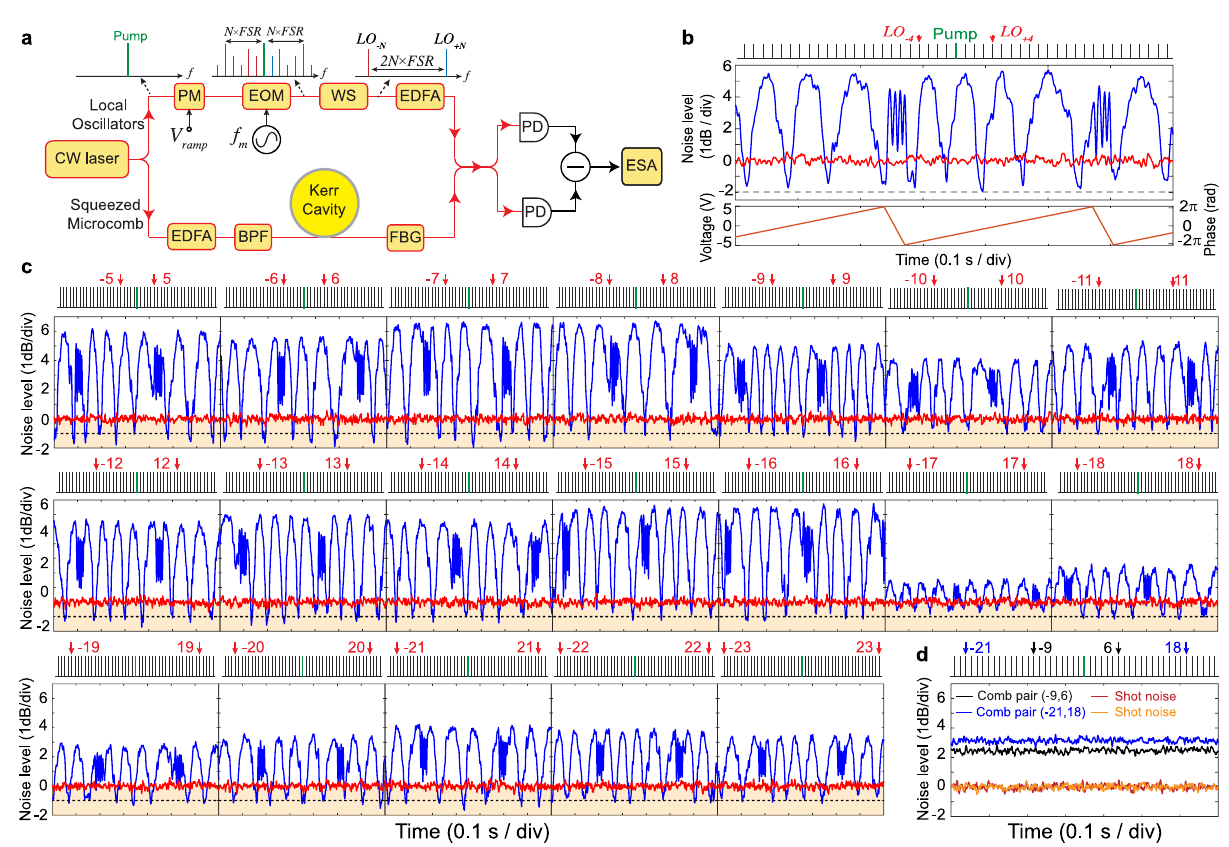
Fig. 2 Two-mode squeezing measurement of 20 comb pairs (40 qumodes) from the microresonator. a Simpli fi ed experimental schematic. A continuous- wave (cw) laser is split to pump the resonator and drive the local oscillators (LOs). The LOs are derived from an electro-optic modulation (EOM) frequency comb, with a comb spacing (modulation frequency) of f m . A line-by-line waveshaper (WS) is used to select a pair of comb lines as the bichromatic local oscillators. The phase of the LOs can be tuned by a phase modulator (PM). The LOs and the squeezed microcombs are combined by a 50/50 coupler and are detected on balanced photodiodes (PDs). The noise level is characterized on an electrical spectrum analyzer (ESA). In the squeezed microcomb path, a fi ber-Bragg grating (FBG) fi lter is used to block the strong pump light. Erbium-doped fi ber ampli fi ers (EDFAs) and optical bandpass fi lter (BPF) are also shown in the fi gure. b Representative quadrature noise variance (blue) relative to shot noise (red) as a function of time for qumodes − 4 and 4 (indicated with red arrows). The lower panel illustrates the ramp waveform applied to the phase modulator to ramp the phase of the LOs periodically with time. 1.6 dB squeezing and 5.5 dB anti-squeezing are directly observed. A dashed black line indicates 2 dB below shot noise level. c Quadrature noise variances (blue) relative to shot noise (red) of all 40 qumodes. The qumodes measured are marked by the red arrows. The regime below the shot noise limit is colored in orange, and a dashed black line indicates 1 dB below the shot noise level. d Quantum correlation check: noise variances show no quantum correlation between uncorrelated comb pairs for qumodes ( − 9, 6) and ( − 21, 18). All measurements are taken at 2.7 MHz frequency, 100 kHz resolution bandwidth, and 100 Hz video are shown as examples in Fig. 4b. At each detuning point, squeezing and anti-squeezing levels can be extracted by averaging the extrema.